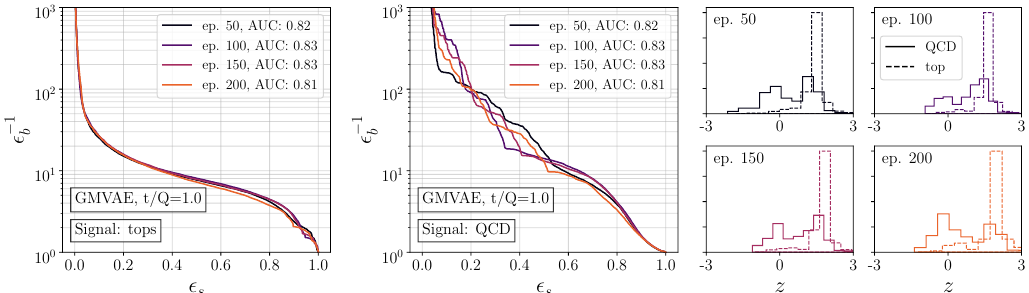
Figure 5: Results for the 1D GMVAE. In the large panels we show the ROC curves for tagging top and QCD as signal. In the small panels we show the distributions of the top and QCD jets in the latent space developed over the